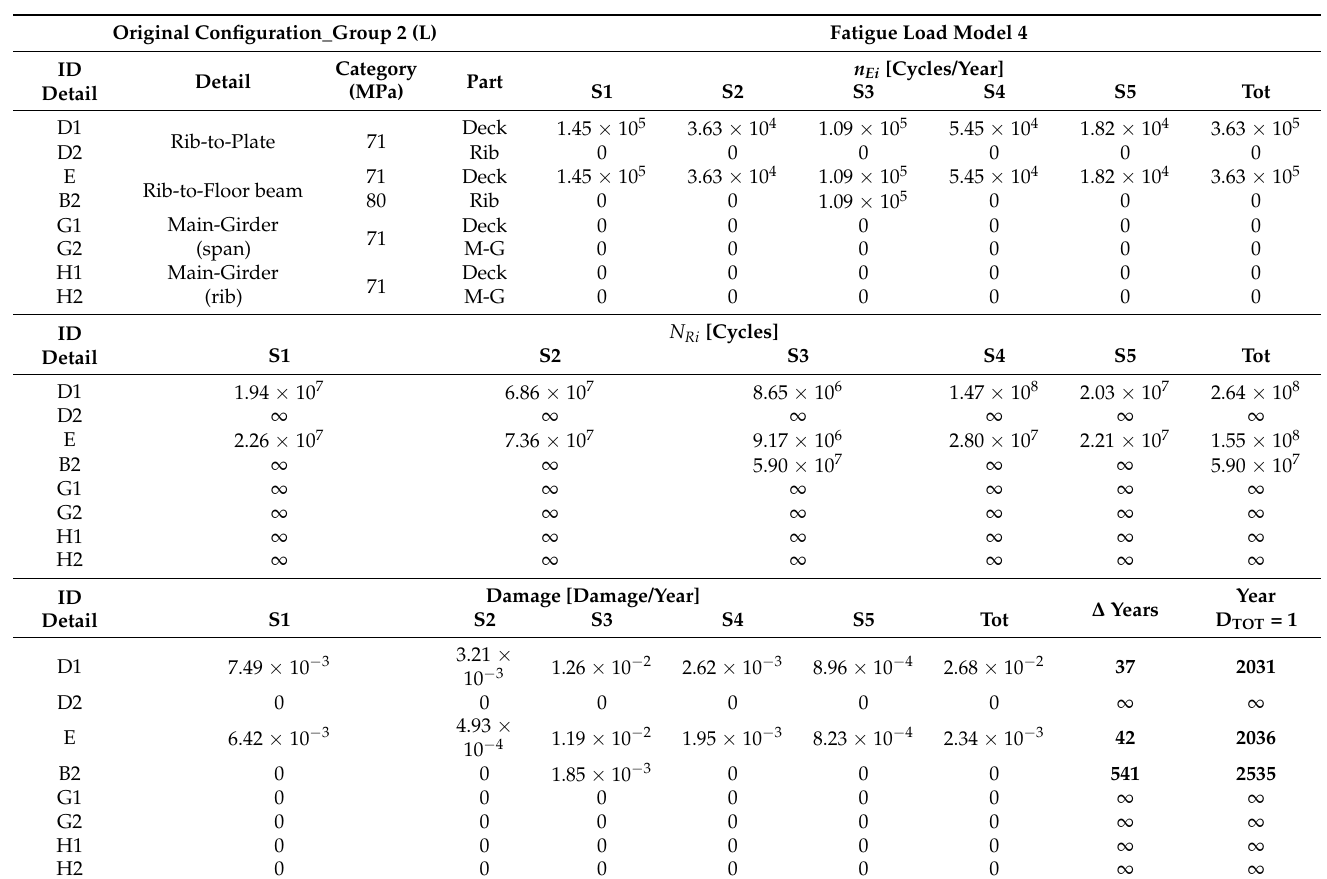
Table 11. Results of damage checks in the original configuration–Group 2